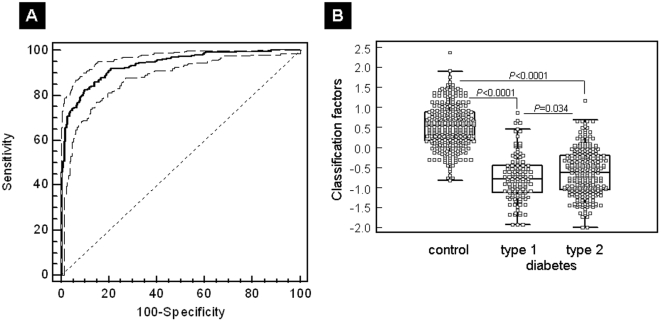
Results for validation of the urinary proteome pattern specific for diabetes.(A) ROC curve for the independent validation set (n = 697). ROC analysis for diagnosis of DM irrespective of diabetes type using a 261 marker panel [11]. An AUC value of 94% was calculated for the discrimination of case and control groups of the multicenter patient cohort (P<0.0001). (B) Box-and-whisker plots of SVM scores for the classified patients. Scores for each individual patient of the validation set are given as open black squares. Medians of T1D [median (interquartile range): −0.78 (−1.12 to −0.45)] and T2D [−0.63 (−1.06 to −0.21)] differed significantly (P = 0.034).